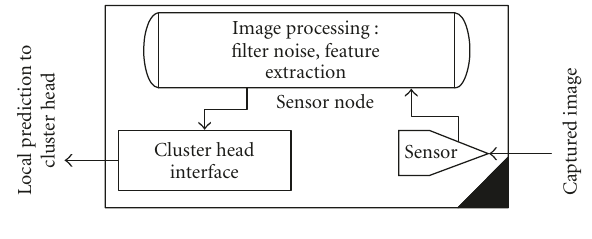
Figure 5: Generic sensor node